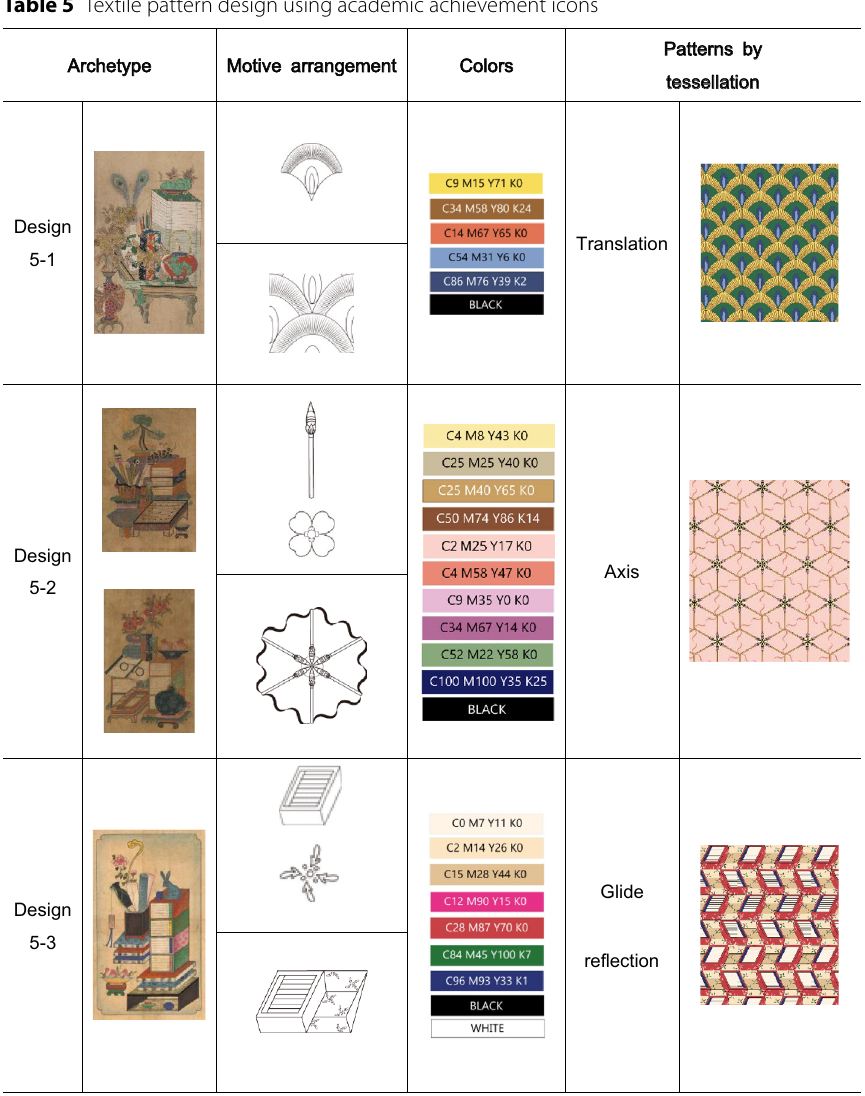
Table 5 Textile pattern design using academic achievement